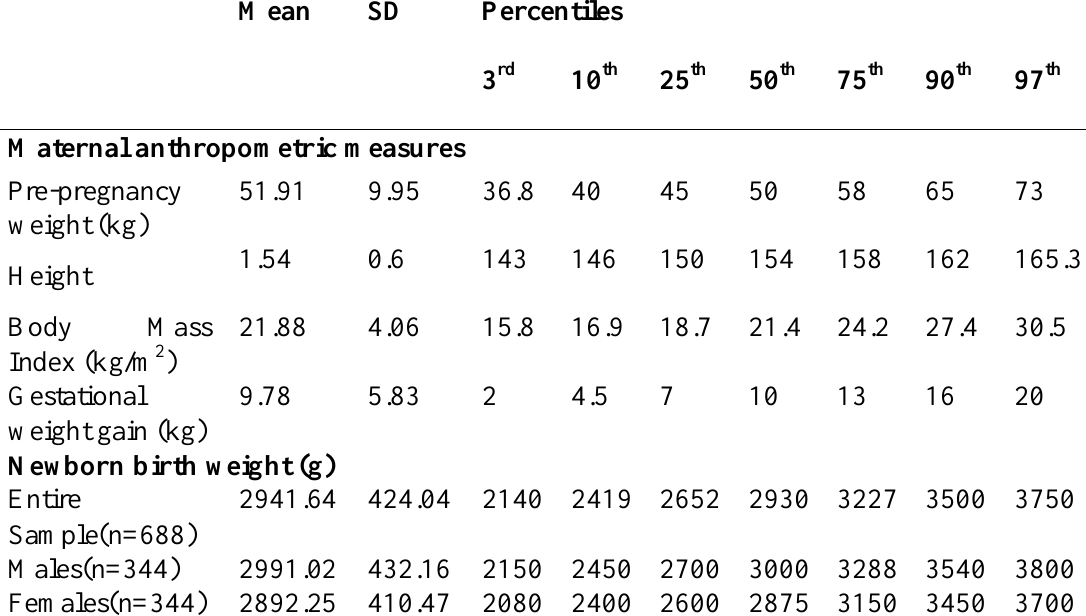
Table 02 - Anthropometric values of mothers and birth weight of full-term